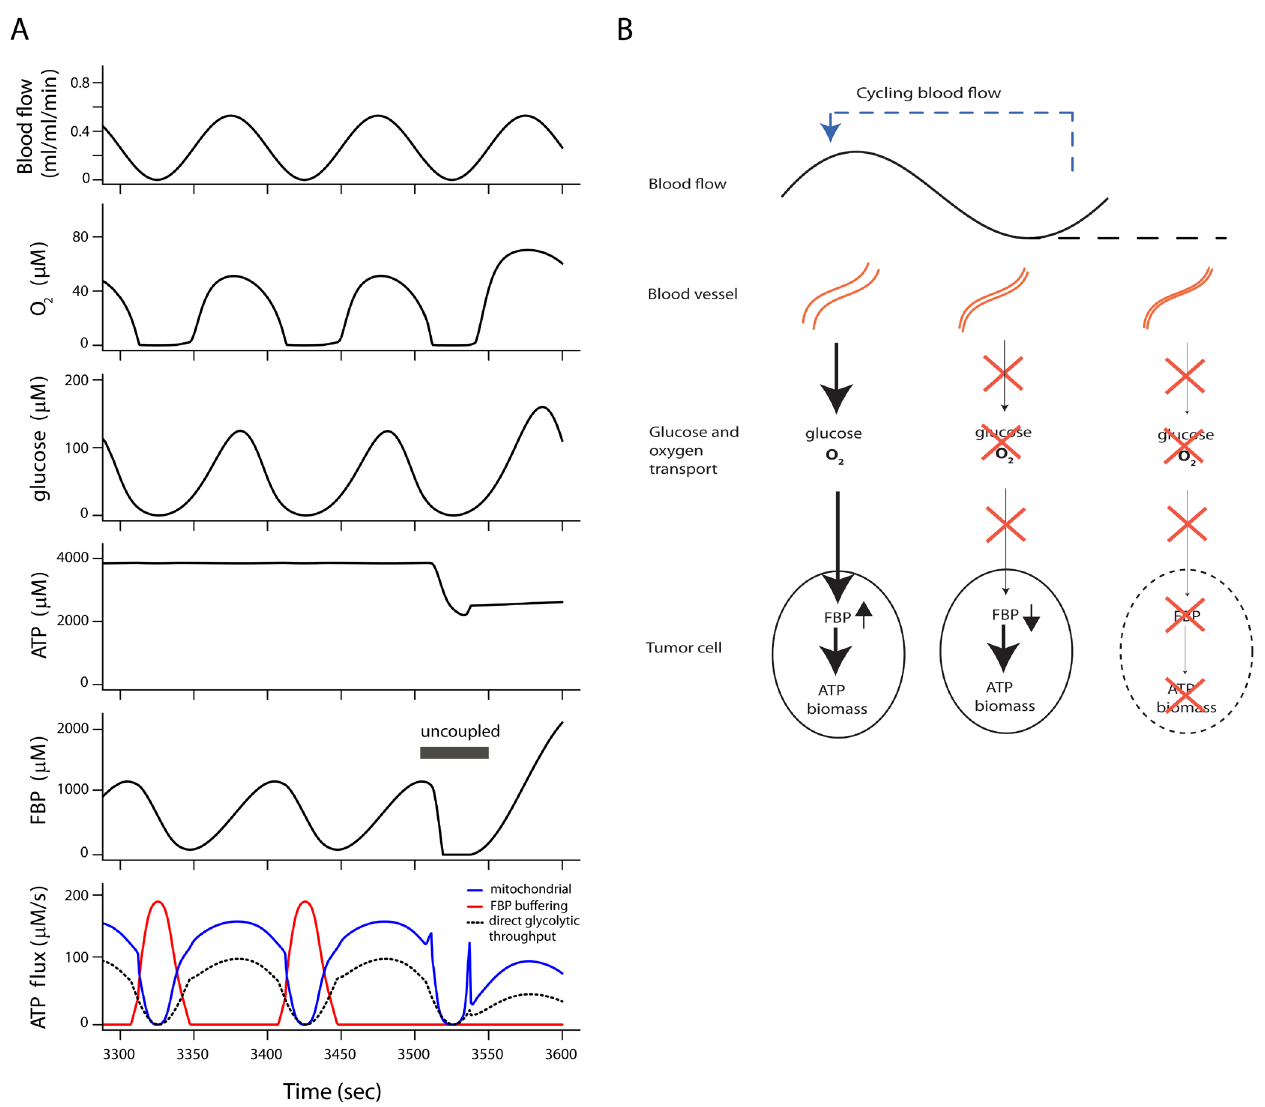
capacity. ATP synthesis by oxidative phosphorylation (blue line) fails periodically during low blood flow because of low oxygen supply. Glycolytic ATP synthesis by direct throughput of FBP from head to tail section fails because of glucose depletion (dashed black line). A burst of ATP synthesis from the stored fructose 1,6-bisphosphate (FBP) and other phosphorylated glycolytic intermediates (red curve) maintains ATP levels during glucose and